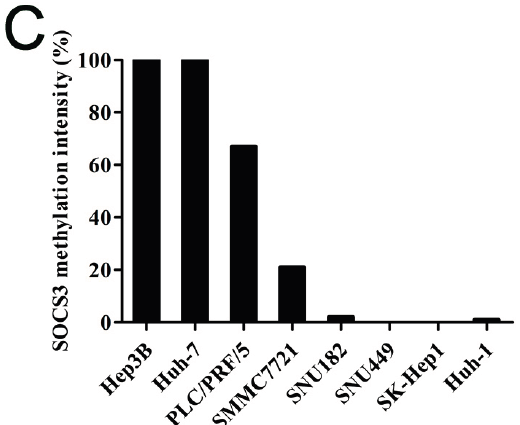
Figure 1. The methylation statuses of two loci of the SOCS3 promoter in HCC tissues and cell lines. ( A ) Schematic representation of the two detected CGI loci of the SOCS3 gene. The transcriptional start site for SOCS3 gene is defined as +1. Shaded boxes are exons of SOCS3 . “ ▼ ” represents the restriction enzyme cutting site; ( B ) The methylation statuses in the located regions of Primer 1 and Primer 2 in 20 pairs of tumors tissues and the adjacent non-tumor tissues; and ( C ) The methylation status of SOCS3 at region 2 in eight HCC cell